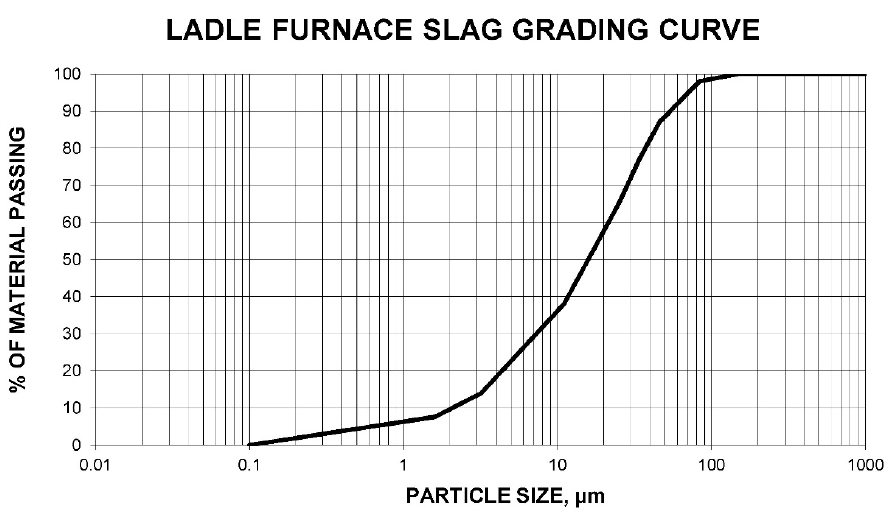
Figure 4. Grading curve of the ladle furnace slag received from the production industry without sieving through the 0.063 mm sieve.